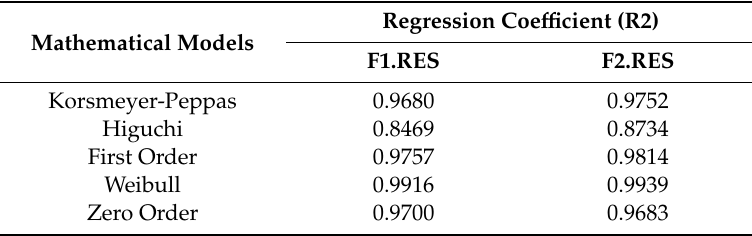
Table 4. Regression coefficient obtained after adjusted the drug release data of tRES-loaded SLN with five mathematical models. Mathematical